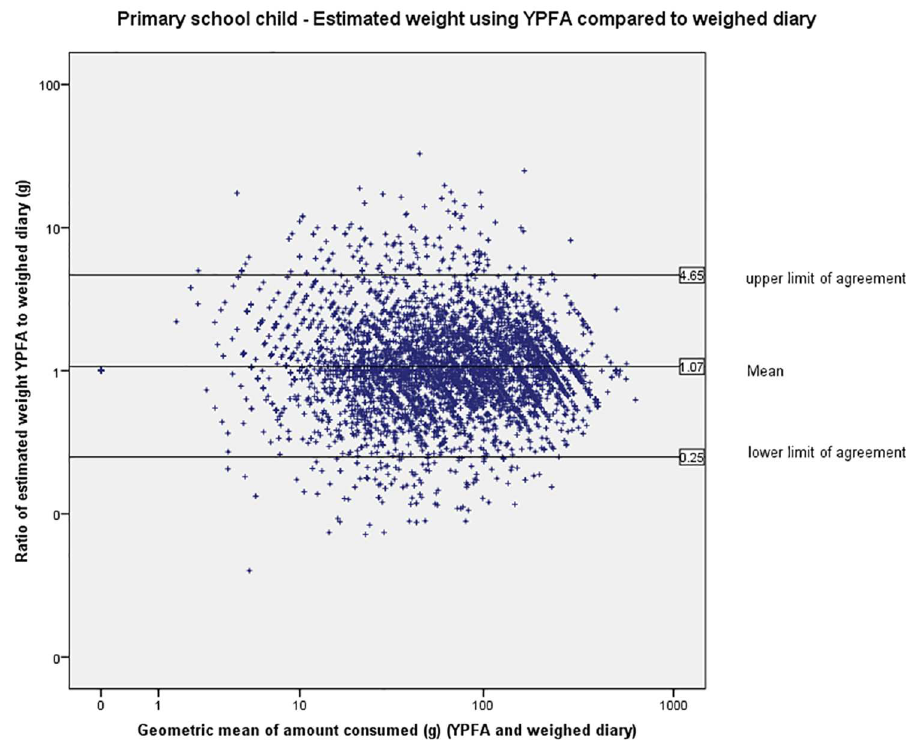
Fig 4. Primary school children—Bland-Altman plot showing estimated weight using YPFA compared to weighed diary.